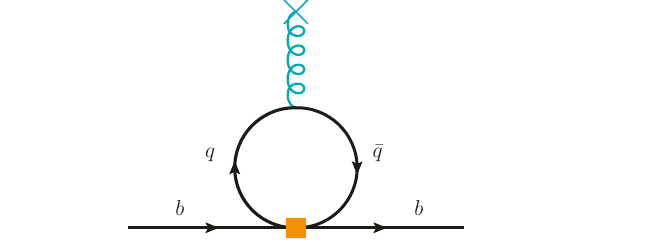
Figure 5 . Diagram contributing to mixing between four- and two-quark operators at